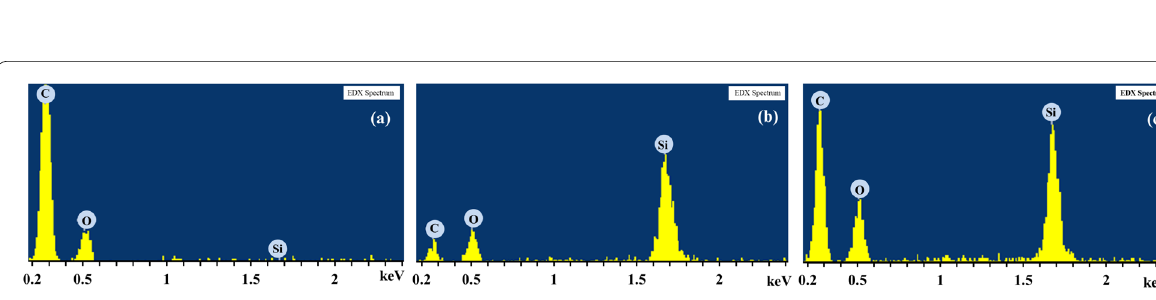
Fig. 5 EDX spectra of a pure PHBV fibers, b PHBV/SiO 2 composite fibers, and c SA modified